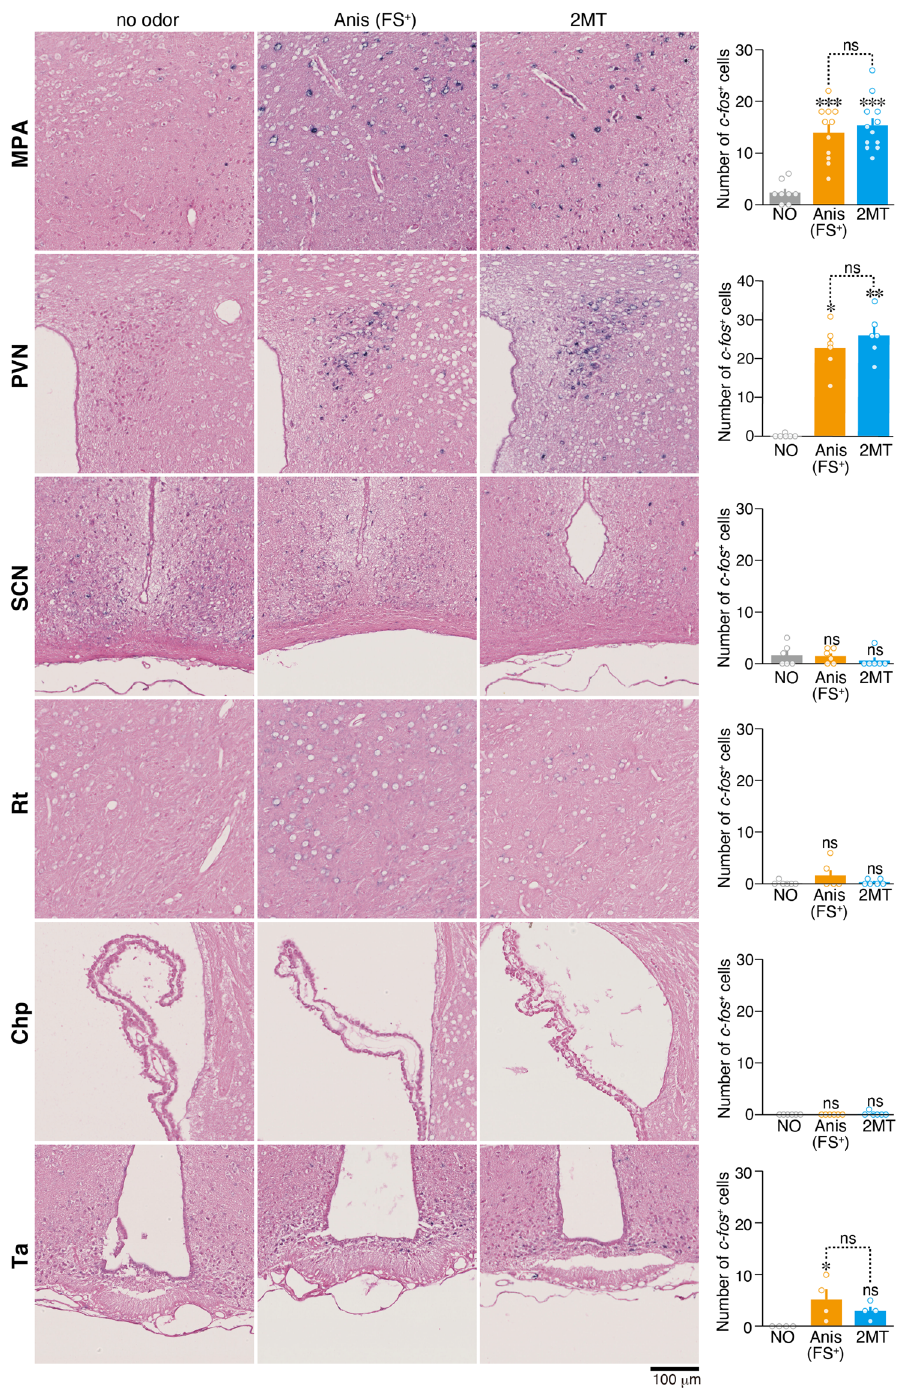
Fig. 5 C-fos mRNA expression analysis of the hibernation/torpor brain areas. Representative images of in situ hybridization of c-fos mRNA in response to no odor, Anis (FS + ), and 2MT in the MPA [ n = 8 for no odor, n = 11 for Anis (FS + ), and n = 12 for 2MT], PVN ( n = 6 each), SCN ( n = 6 each), reticular thalamic nucleus (Rt) ( n = 6 each), choroid plexus (Chp) ( n = 6 each), and Ta ( n = 4 each). Quanti fi cation of c-fos + cells are also shown. Data are means ± SEM. One-way ANOVA followed by Tukey ’ s multiple comparison was performed. * P < 0.05; ** p < 0.01; *** p < 0.001; n.s., p >